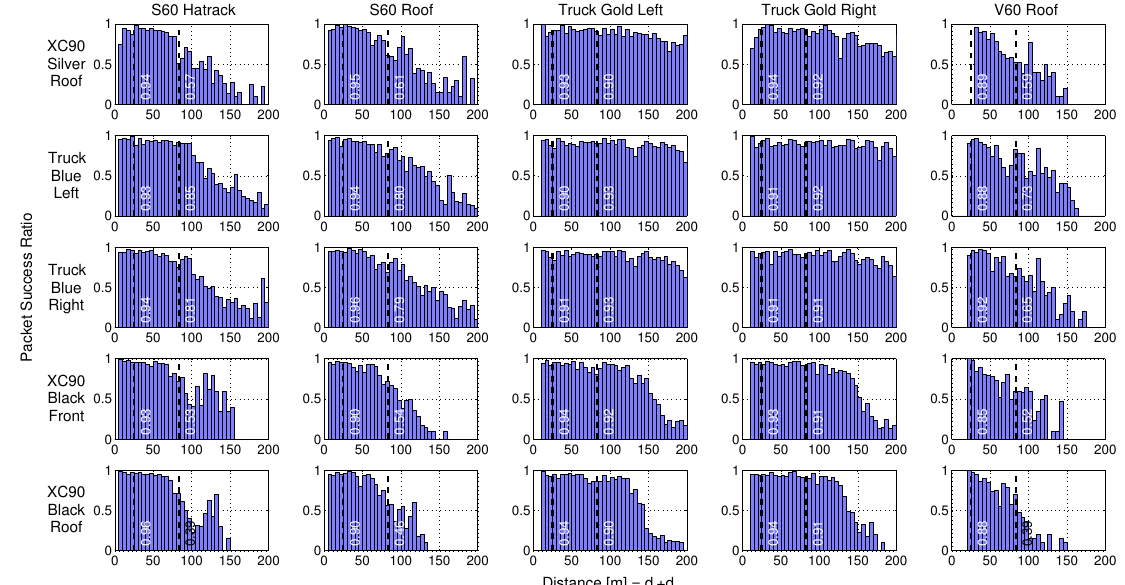
Figure 6. The packet success ratio vs. the Manhattan-distance ( d t + d r ) for all 25 analyzed simultaneous NLOS communication links between the two groups at intersection Yngve. The rows represent the vehicles in group 1, and the columns represent the vehicles in group 2. The first dotted line from the left is roughly the breaking distance (without reaction time) needed for two cars to avoid collision at a speed of 50km/h (14m/s). The second dotted line is the "three-second safety distance recommendation" by Swedish traffic schools to avoid a collision at the same speed, which corresponds to 83.3m. The white numbers close to the dotted lines represent the packet success ratio of receiving a single packet transmitted within one second before the dotted lines, from each vehicle,